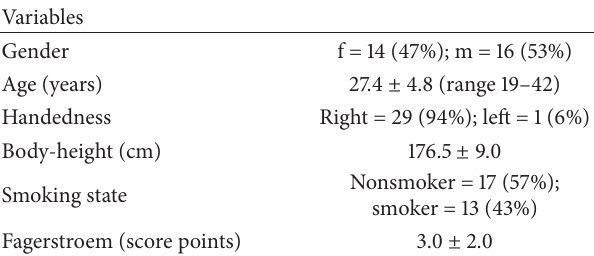
Table 1: Descriptive statistics of the data sample (data presented as mean ± standard